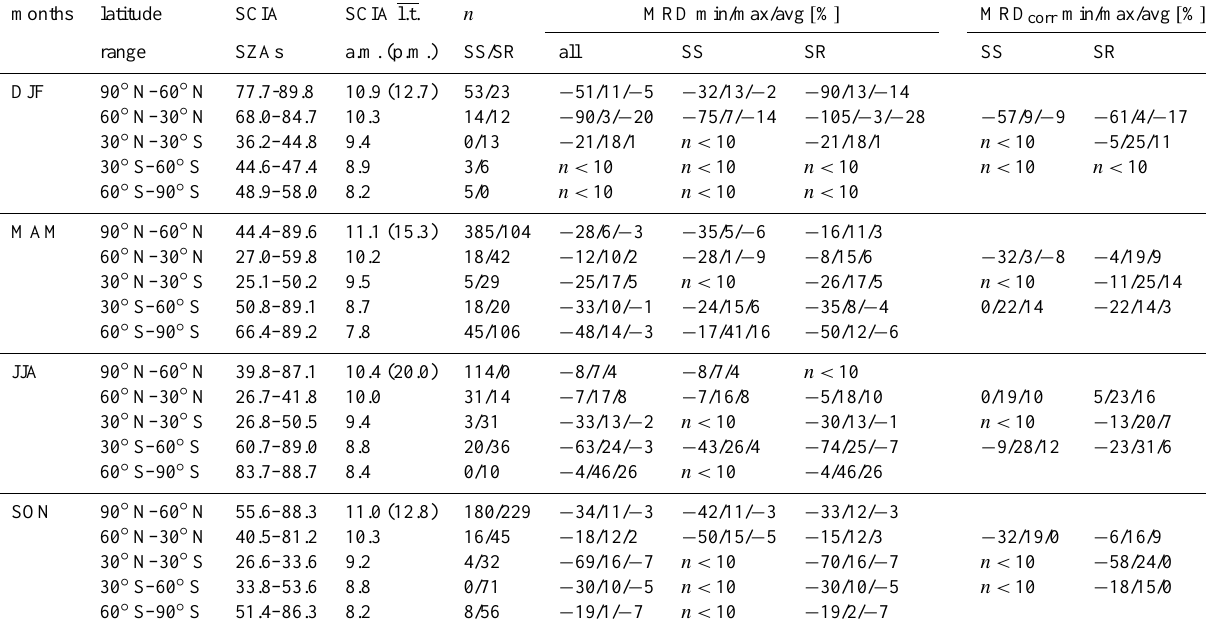
Table 4. Same as Table 2, but for ACE-FTS collocations. An altitude range from 20 to 40km is covered. months latitude SCIA SCIA l.t. MRD min/max/avg [ % ]